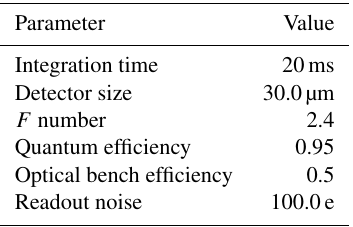
Table 1. A table for default parameter settings in our